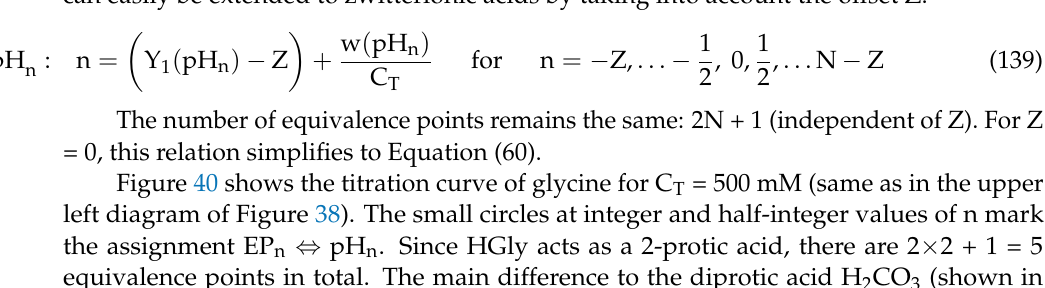
are interchanged here.]